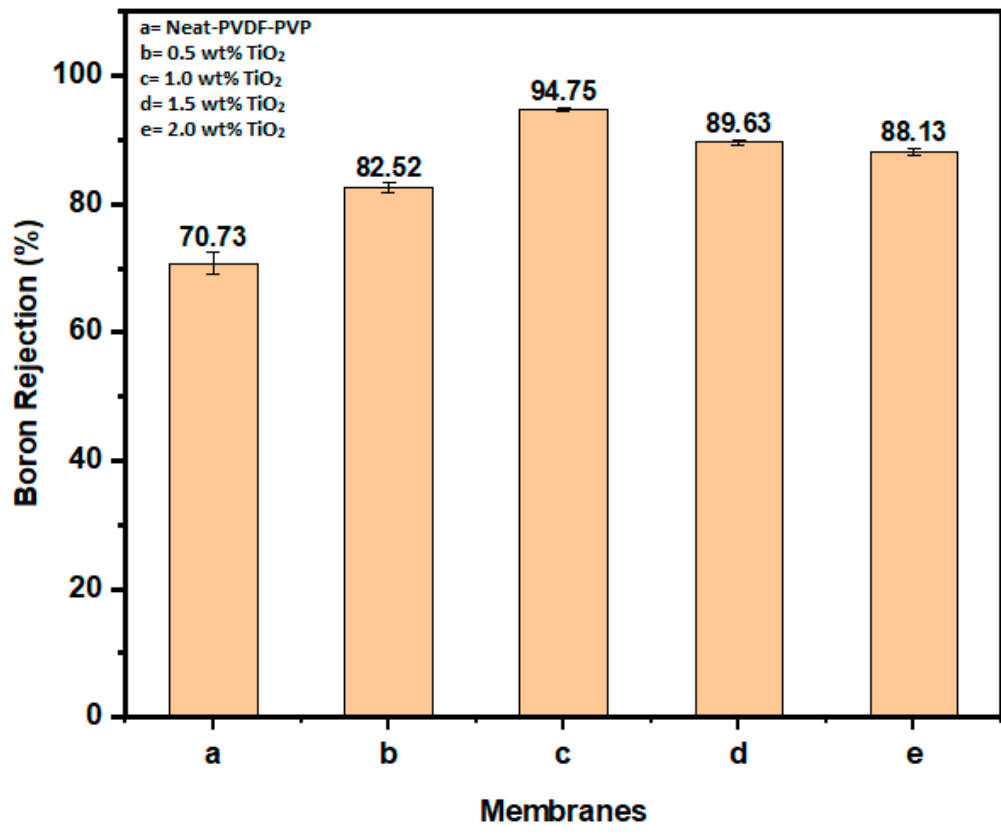
Figure 6. Boron rejection of neat PVDF-PVP ( a ) and membranes modified with TiO 2 ( b – e ).